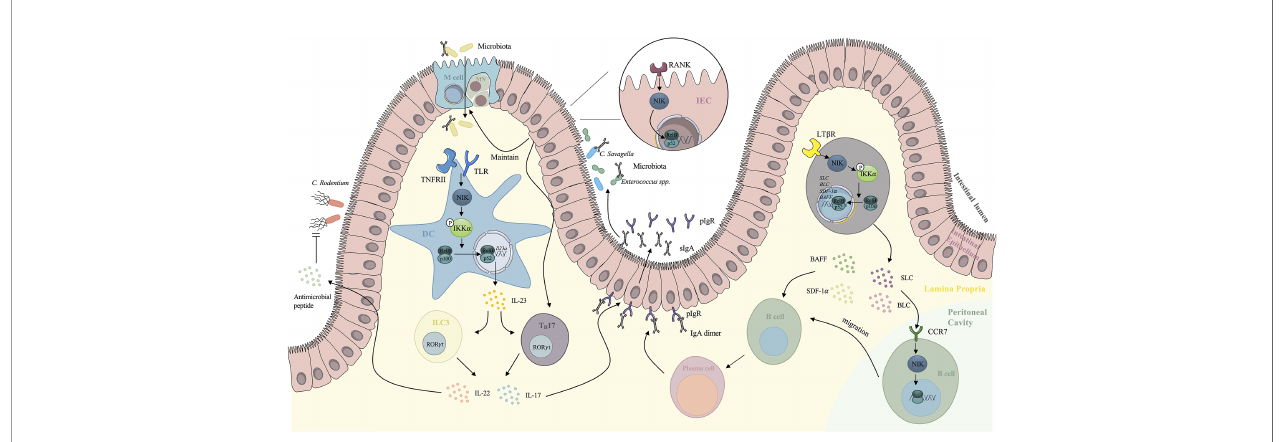
FIGURE 2 | Mechanism of NIK signaling-mediated regulation of intestinal adaptive immunity. TLR, together with TNFRII induces NIK signaling in DCs. The nuclear translocation of RelB/p52 enhances the expression of IL-23, which maintains the TH17 cells and ILC3s. IL-17 secreted by TH17 cells and ILC3s stimulates the expression of pIgR on the basal surface of IECs, which increases the secretion of IgA to intestinal lumen. IL-22 secreted by TH17 cells and ILC3s also stimulates antimicrobial peptide against Citrobacter rodentium . NIK signaling downstream of RANK on IECs mediates the maintenance and differentiation of M cells, which facilitates the delivery of antigens to immune cells. NIK in IECs also induces IL-17 expression and IgA secretion, which enhances the intestinal immunotolerance. NIK signaling also modulates the migration of peritoneal cavity B cells to GALTs. Under the stimulation of SLC and BLC, NIK is activated in peritoneal cavity B cells and it mediates the migration. NIK participates in the downstream of LT b R in the intestinal stromal cells as well via upregulation of SDF-1 and BAFF, providing the microenvironment for B cells maturation. NIK also upregulates SLC and BLC, inducing B cells migration. NIK, NF- k B inducing kinase; DCs, dendritic cells; ILC3, type 3 innate lymphoid cells; IECs, intestinal epithelial cells; M cells, microfold cells; GALT, gut associated lymphoid tissue; SLC, secondary lymphoid tissue chemokine; BLC, B lymphocyte chemoattractant; BAFF, B-cell activating factor belonging to the TNF